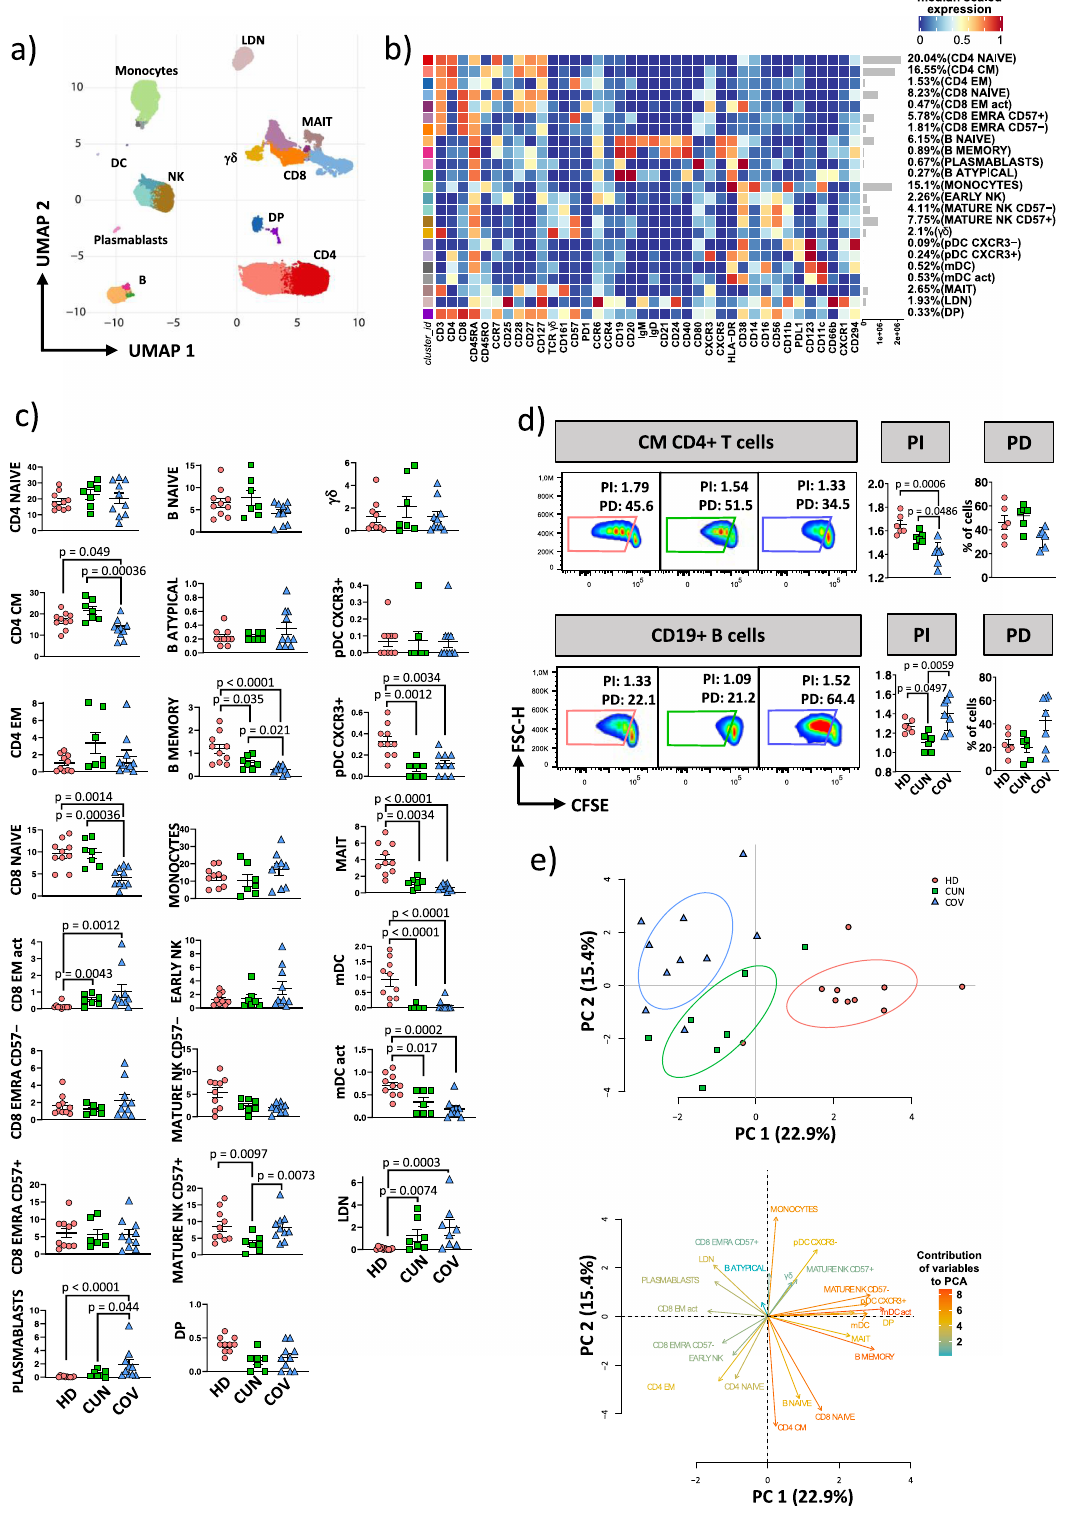
The principal components analysis (PCA), related to data regarding the complete phenotype obtained by CyTOF, revealed that COV and CUN patients cluster in different positions of the two-dimensional PCA space (Fig. 2e, upper panel). Immune features related to the amount of LDN, plasmablasts and activated EM